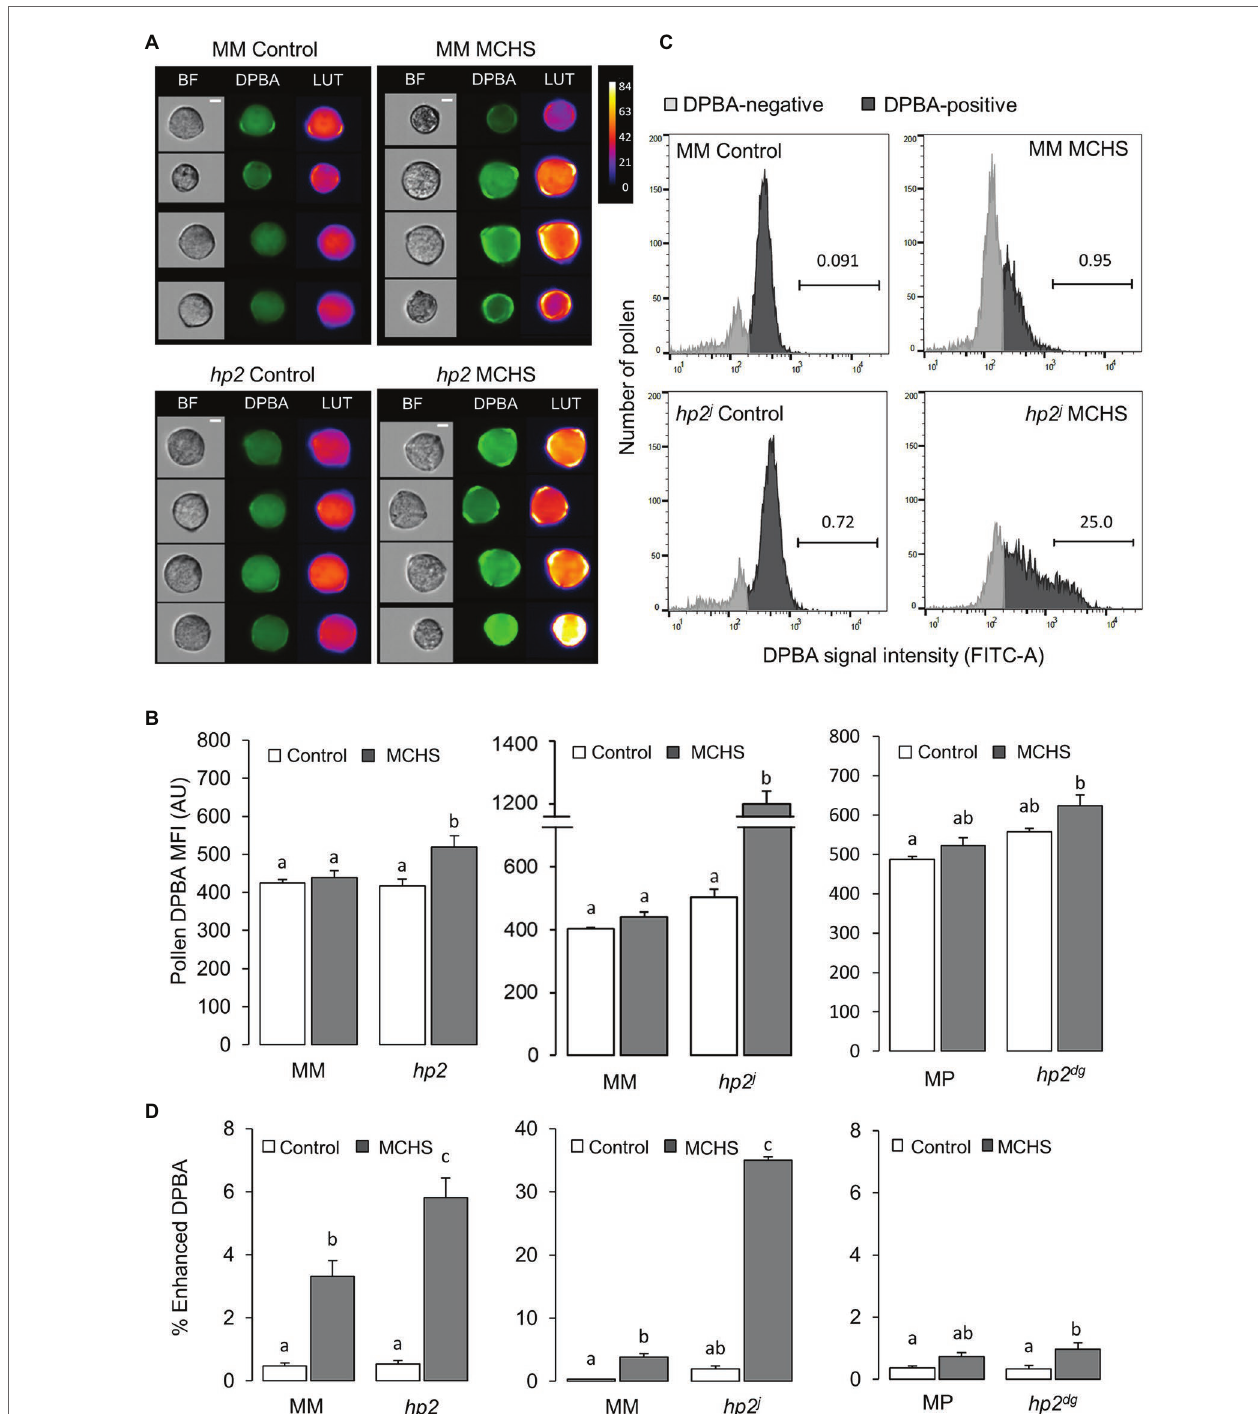
FIGURE 5 | The hp2 mutant accumulates higher levels of flavonols in pollen in response to MCHS. (A) Randomly selected pollen grains from DPBA-stained samples of hp2 and Moneymaker under control and MCHS conditions. Pseudo-color LUT images indicate the scale of DCF fluorescent intensity. BF, bright field images. Scale bar = 10 μ m. (B) Pollen flavonol levels under control and MCHS conditions by DPBA stain mean fluorescence signal intensity (MFI) presented in arbitrary units. (C) Pollen distribution by DPBA signal intensity in hp2j samples from control and MCHS conditions. Horizontal bars mark the enhanced-DPBA pollen subpopulation and the above number denotes the percentage of this subpopulation out of total DPBA-positive pollen. (D) Percentage of enhanced DPBA (i.e., enhanced flavonols) subpopulation under control and MCHS conditions. Error bars represent SEM, derived from 3 to 6 replicates. Different letters indicate statistically significant differences. MCHS, moderate chronic heat stress; MM, moneymaker; MP, manapal; and AU, arbitrary